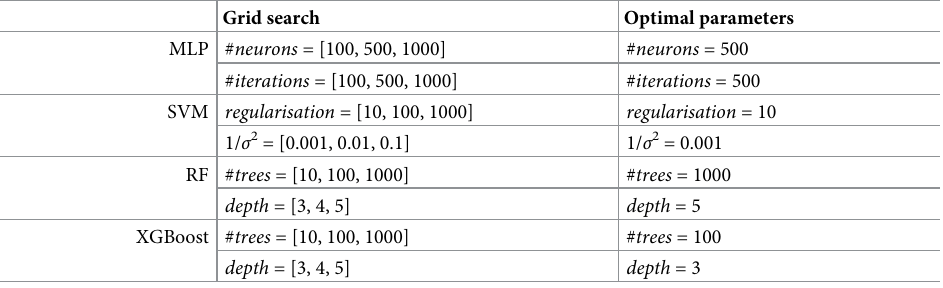
Table 1. Parameter settings for the prediction models, where # neurons is the number of neurons, # iterations is the maximum number of iterations, regularisation is the regularisation parameter, σ 2 is the variance within the RBF kernel, # trees is the number of trees, and depth is the maximum depth of the tree.